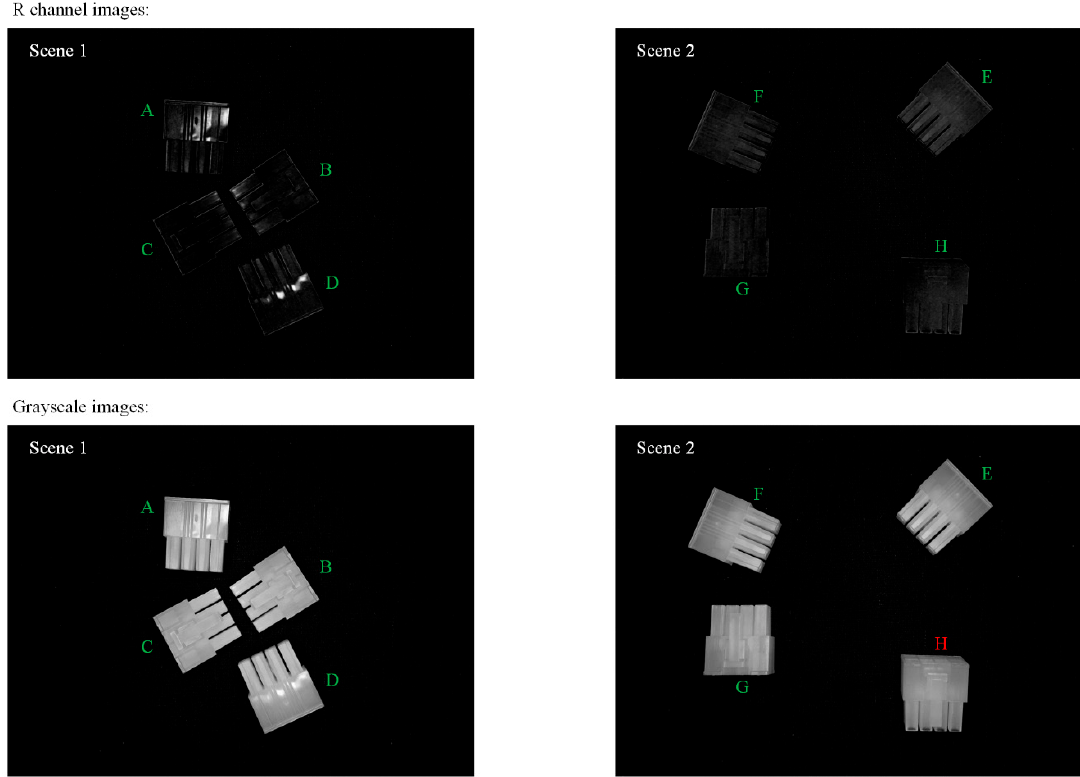
Figure 7. R-channel images, greyscale images for the two scenes under the optimal design of Condition III [illumination RGB (red, green and blue) equals to 15, 225 and 240, with a wide FOV], and their recognition results. Objects labelled in green were those that could be correctly recognised, while the red one could not be recognised.